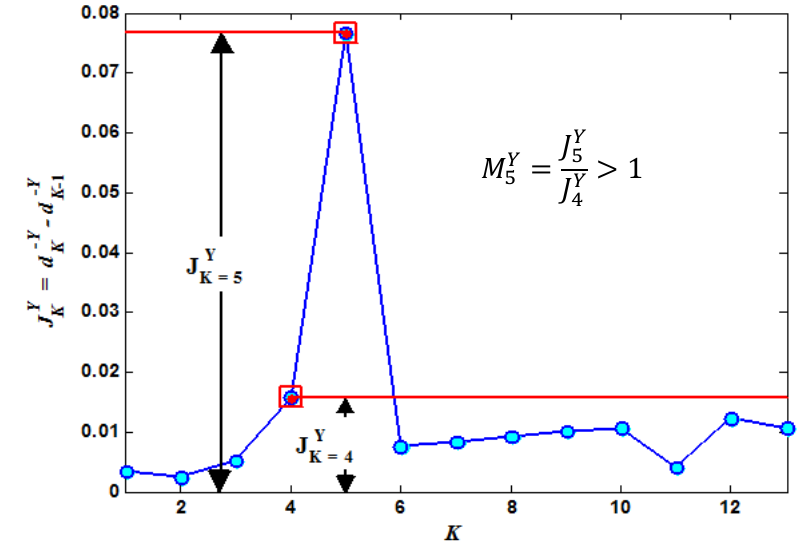
Figure 1. An illustration of the selection of K * = 5 from the largest margin operator. The jump statistics are generated from five 3D Gaussian clusters, where Y = 2.5. Figure from Reference